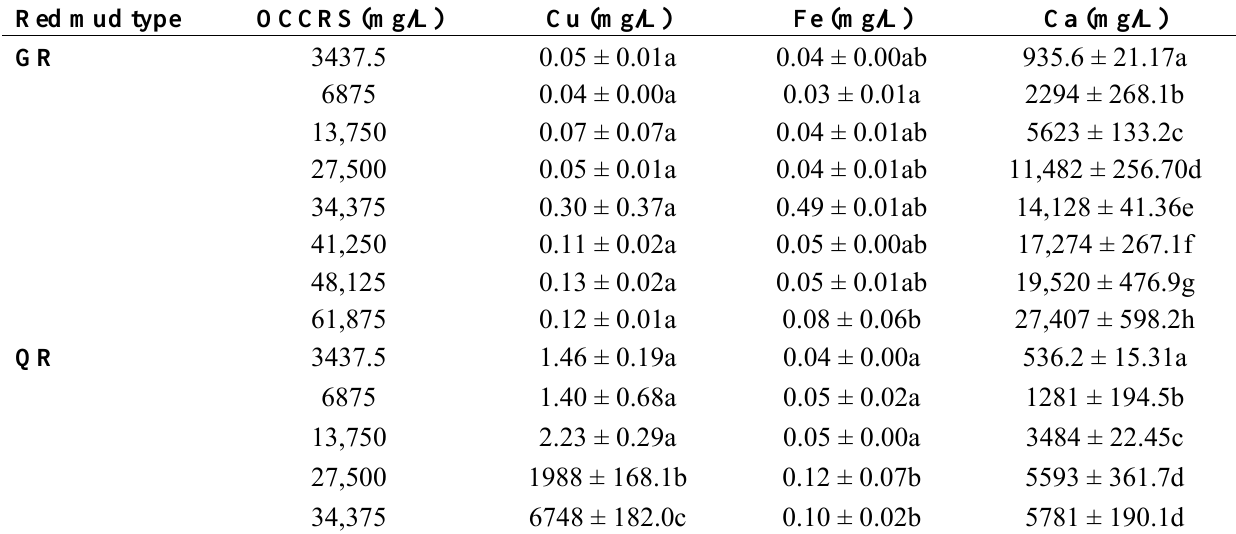
Table 2. Concentrations of Cu, Fe and Ca in the reacting solutions after 16 h reaction for the two red mud